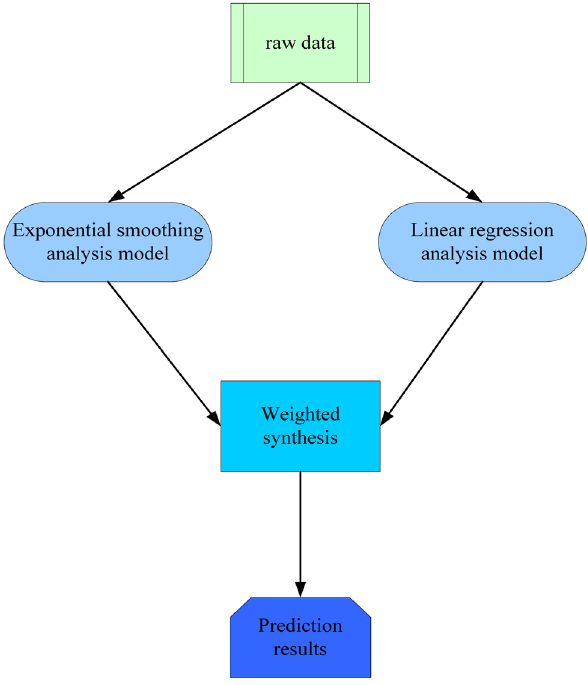
Figure 5: Predictive model of intelligent